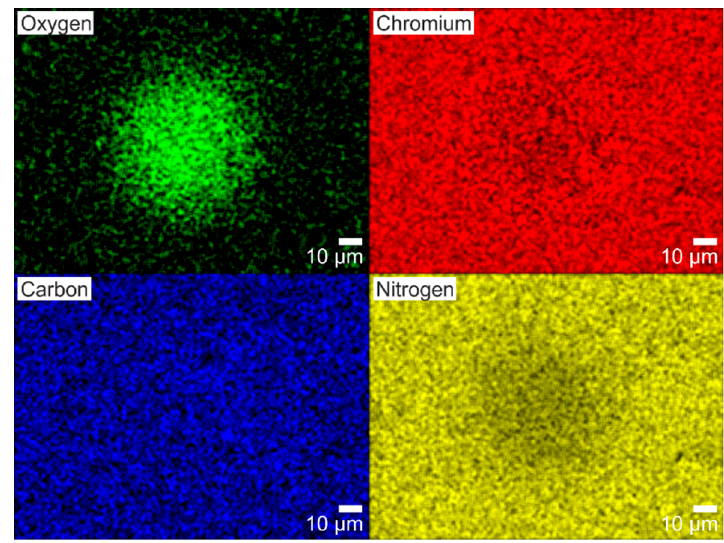
Figure 6. EDX analysis of the fs-laser irradiated spot shown in Figure 5A, where the concentrations of oxygen, chromium, carbon and nitrogen are displayed in false colors. Brighter colors indicate larger signals. Note that the spatial distribution of oxygen is consistent with the irradiated spot shown in Figure 5A.